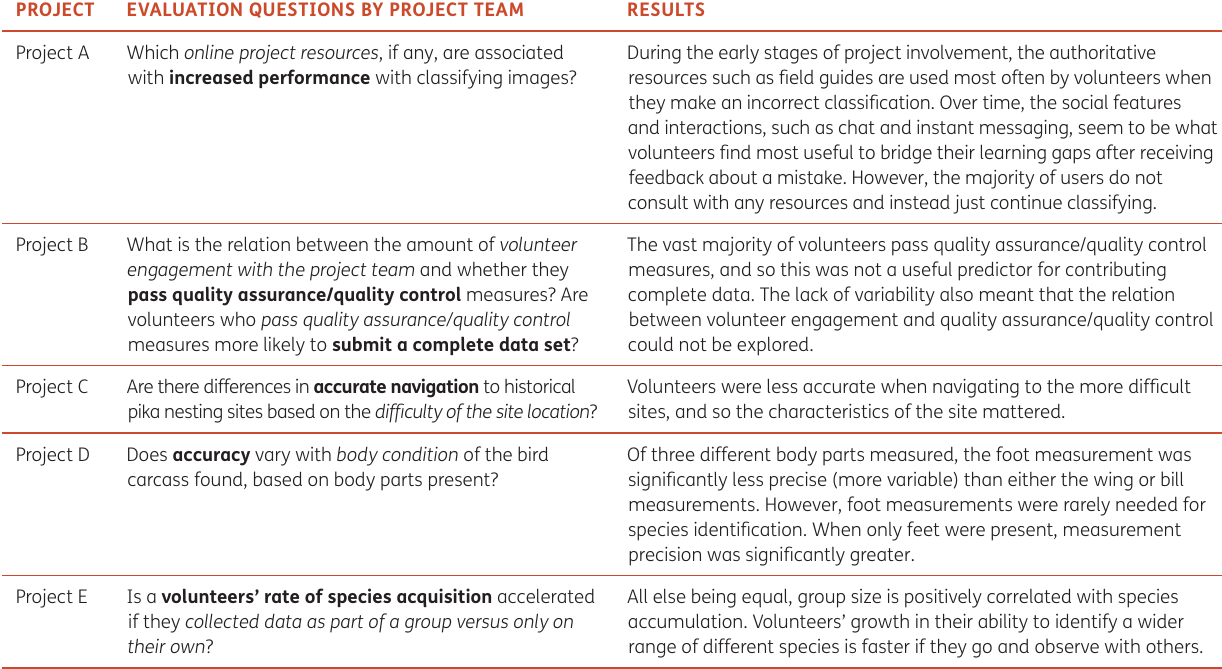
Table 4 Sample evaluation questions and summary of results. Bold text is used to indicate the dependent variable (i.e., volunteer skills being studied). Italicized text is used to indicate additional independent variables that were